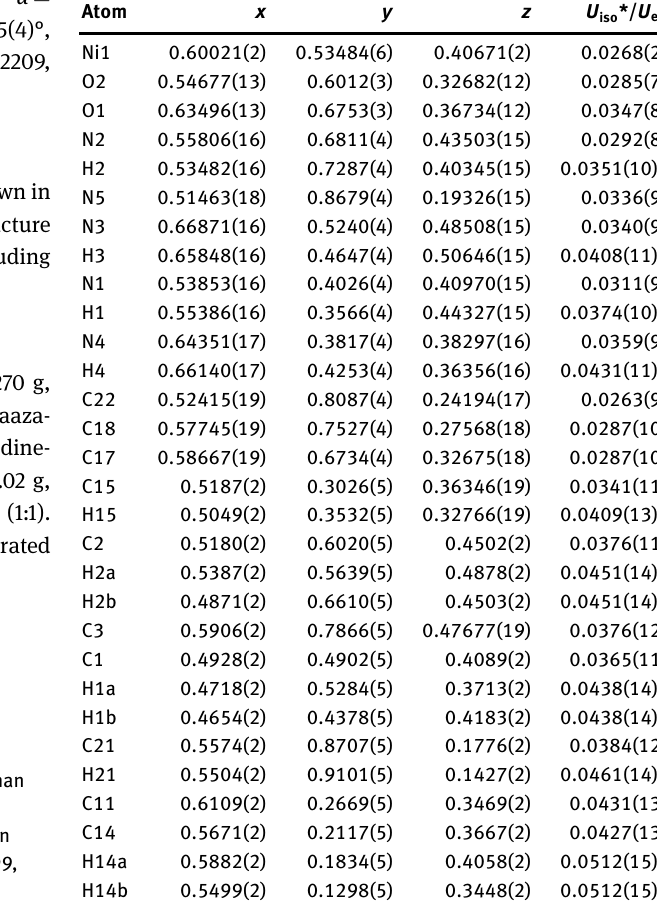
Table 2: Fractional atomic coordinates and isotropic or equivalent isotropic displacement parameters (Å 2